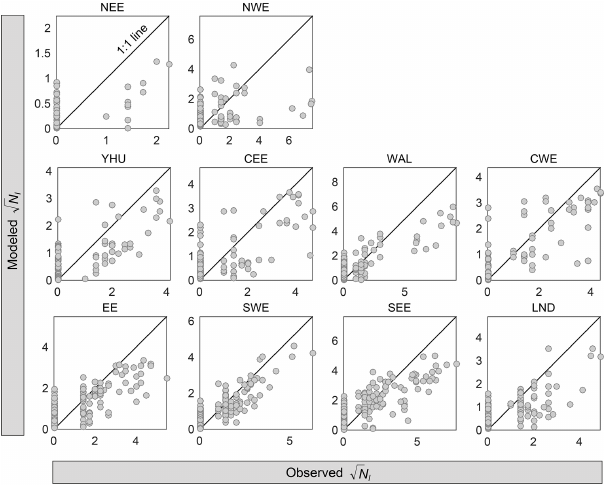
Figure 10. RF predictions for different regions in the UK (trans- formed variables).